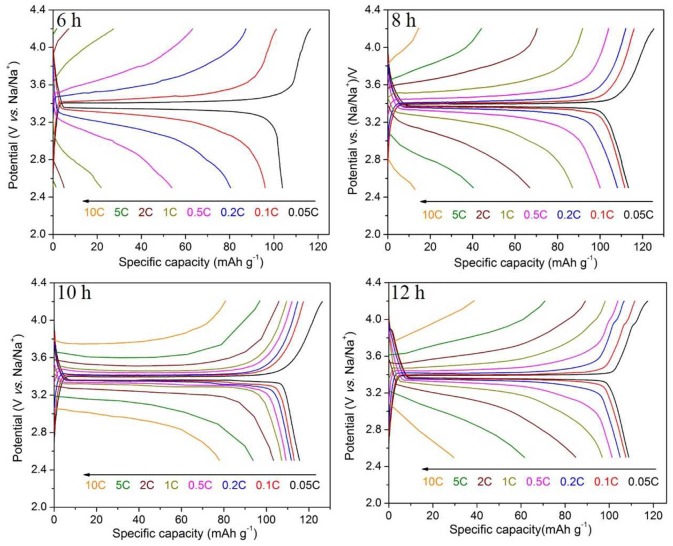
Charge/discharge curves of Na3V2(PO4)3/C synthesized at different calcining times.